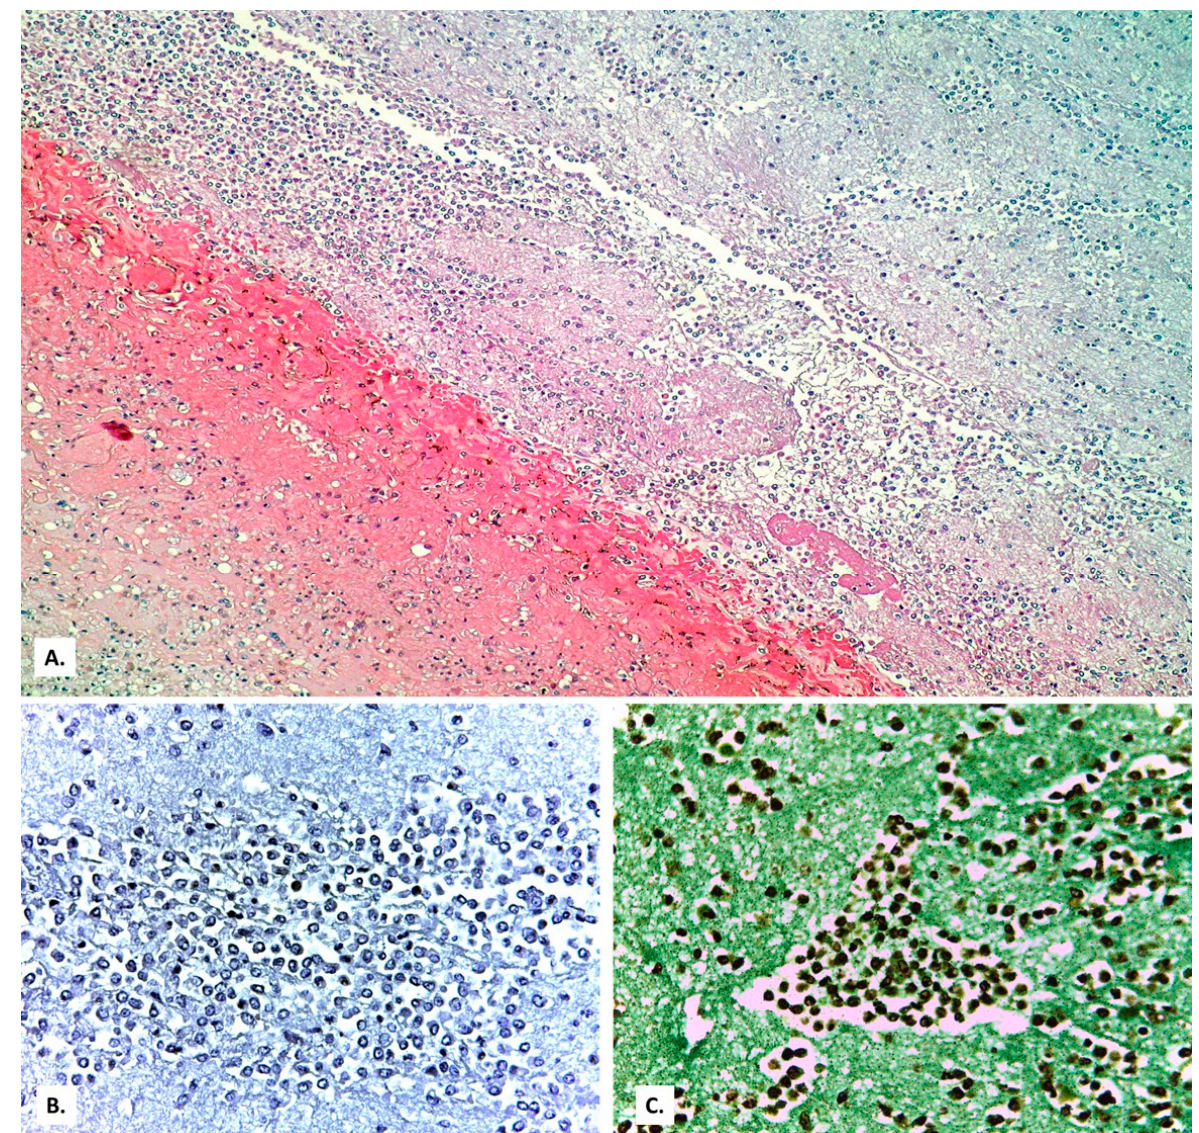
Figure 12. ( A ) Eosinophilic filaments of fibrin at the contact with the pleura, covered by a cell-rich basophilic material (HE × 100). ( B ) Giemsa stain and ( C ) Grocott-Gomori’s methenamine silver stain are positive.